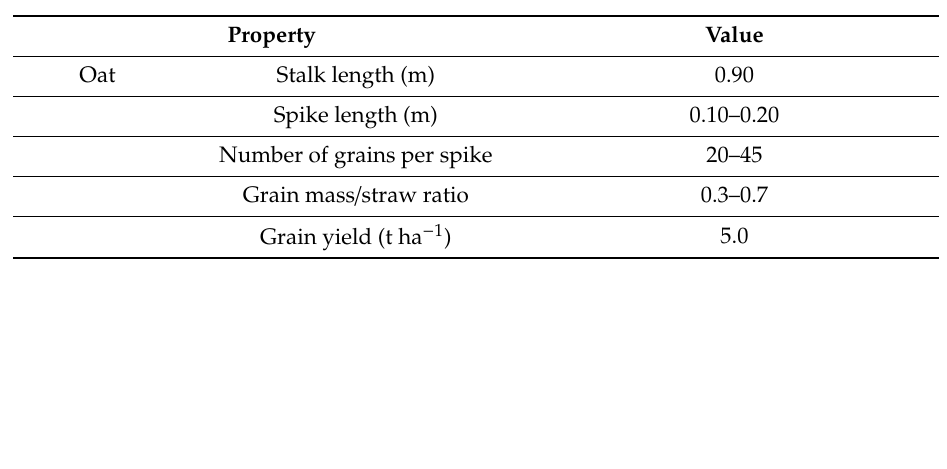
Table 2. Selected properties of oats (type Kasztan) and cha ff used in